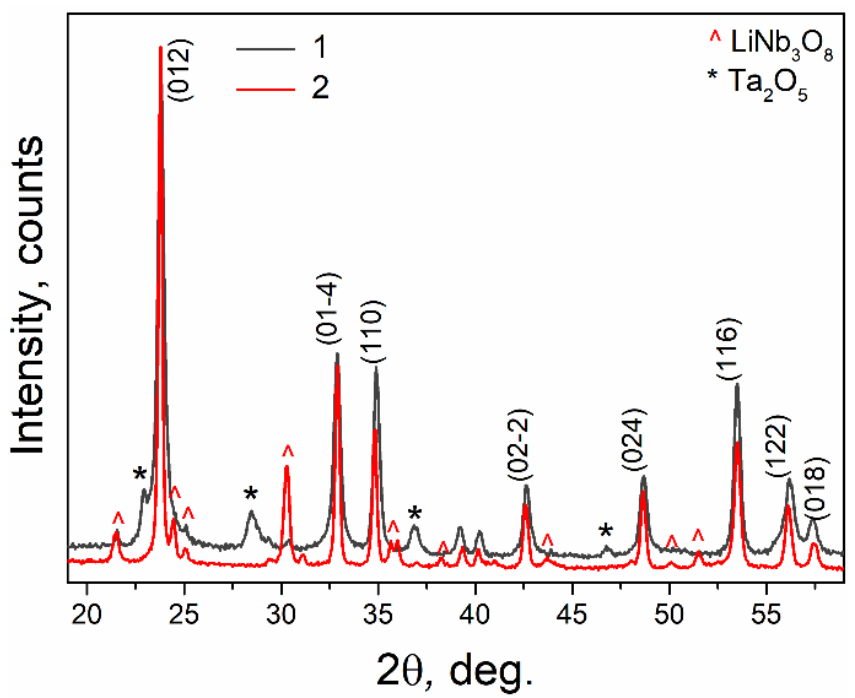
Figure 5. XRD patterns of the “S04” sample with a nominal composition LiNb 0.25 Ta 0.75 O 3 heat treated at 550 ◦ C and 800 ◦ C. For the main rhombohedral LN-LT phase, the Miller’s indices are given ( 1 —S04 at 550 ◦ C; 2 —S04 at 800 ◦